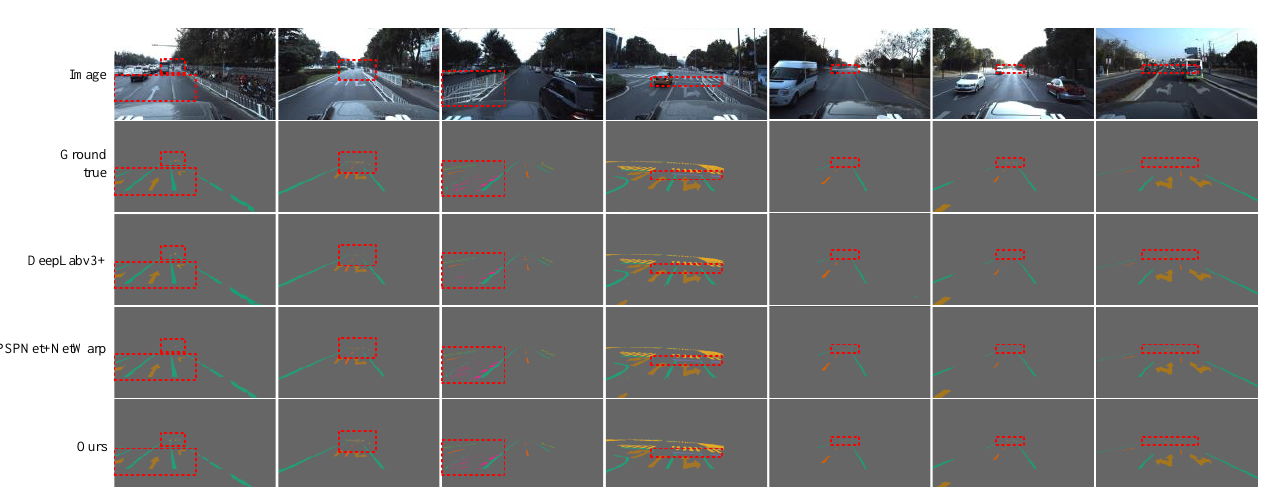
Figure 11. Some examples of the segmentation results of lanes and road markers on the Apolloscape lanemark segmentation dataset by our model are presented. Our model can obtain more information from adjacent frames and segmentation better by using clipping-net branch and optical flow optimized network. We indicate the obvious segmentation differences between the different methods with a red dotted